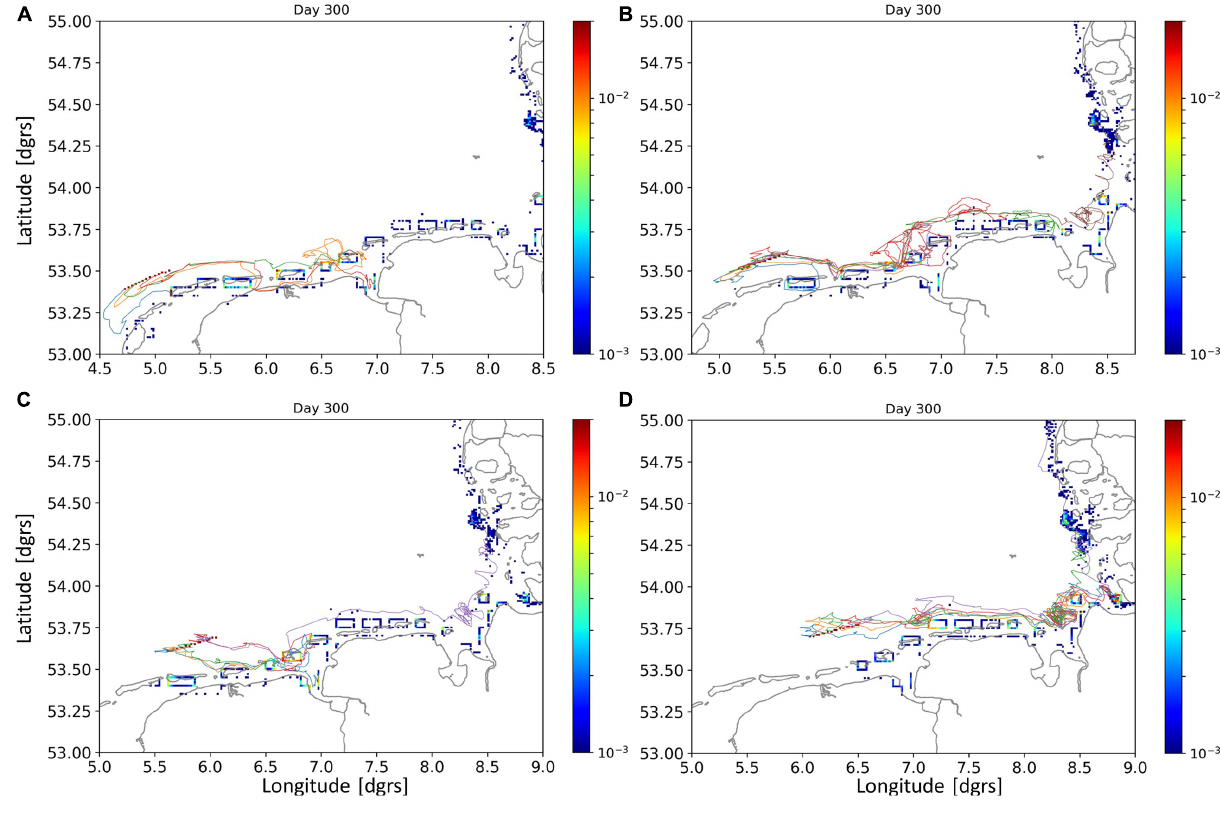
FIGURE 9 | Results of releases of particles representing PS grains from four parts of the trajectory of MSC Zoe. Colors represent the fraction of particles released that arrived in a 1 × 1 km rectangle. Vertical velocity was − 0.004 ms − 1 and the horizontal diffusion coefficient was 0.5 m 2 s − 1 . TABLE 3 | Percentage of particles representing PS grains remaining in the Netherlands, or reaching Germany or Denmark, for releases on four parts of the trajectory of MSC Zoe (see also Figure 9 ), and different settings for the vertical partical velocity and horizontal diffusion coefficient. Part of